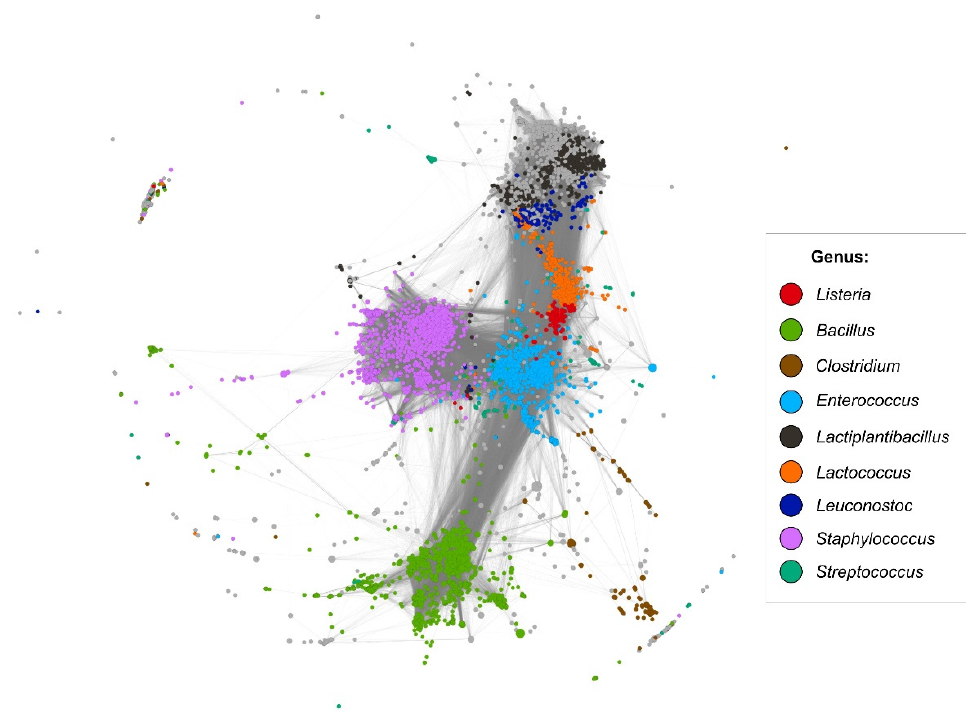
Figure 6. Protein ‐ based similarity network of Firmicutes plasmids (sequences available in GenBank). Each node ( n = 5533) represents a complete plasmid sequence with the size of the node corresponding to the size of the plasmid. Colors indicate the host genus of the most prevalent groups (>2% of the presented plasmids belonging to this genus). Plasmids originating from the remaining hosts are represented in grey. Edges reflect similarity between connected nodes.